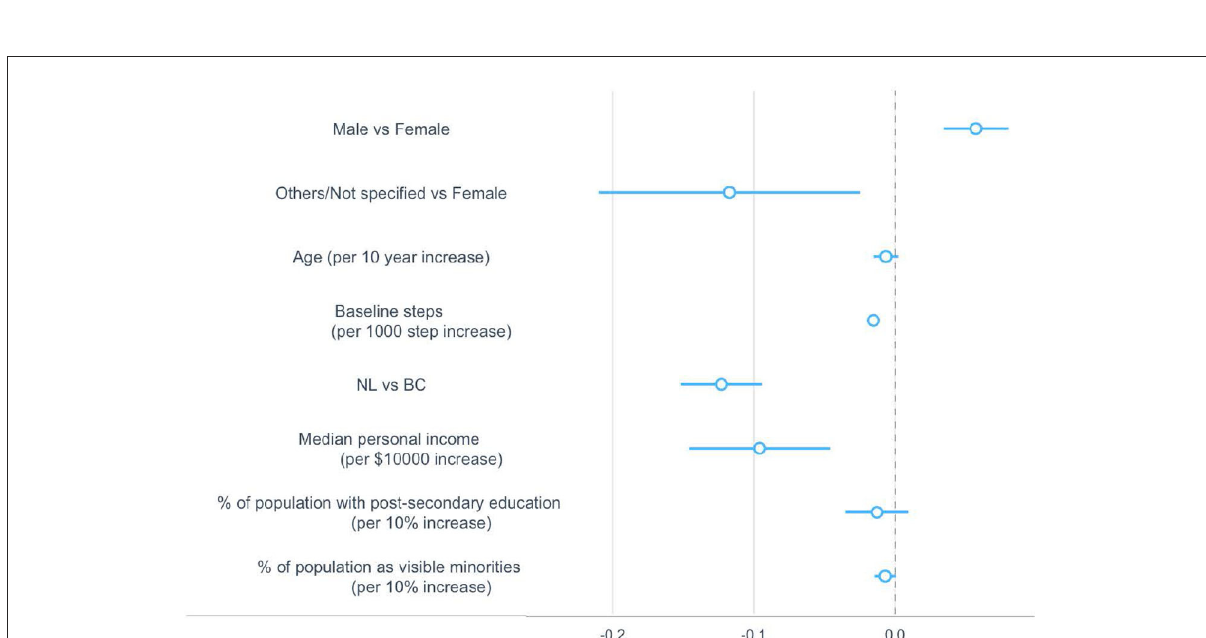
FIGURE5 Regression coefficients and 95% confidence intervals for sociodemographic correlates associated with the number of streaks. The dotted vertical line indicates a mean difference of zero, which means a correlate neither increased nor decreased the number of streaks. BC, British Columbia; NL, Newfoundland and